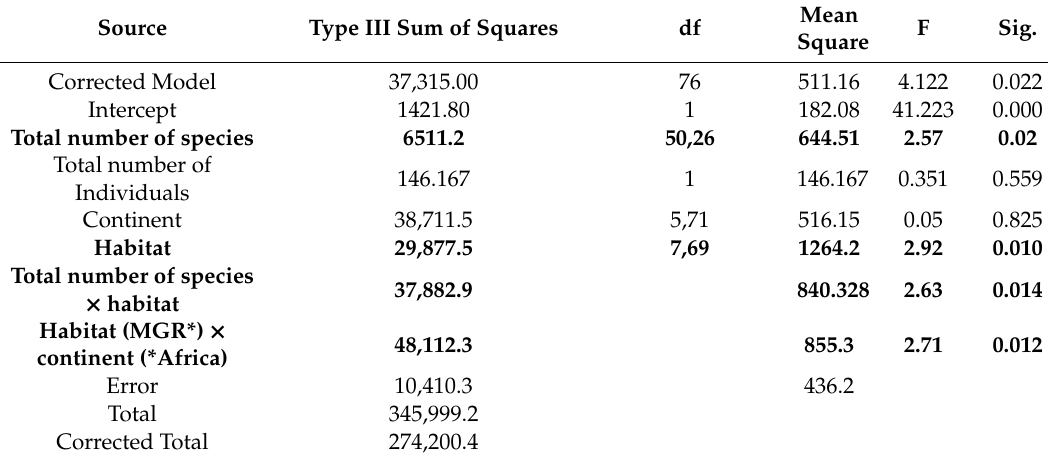
Table 8. Results of GLM regarding the probability of an increase of the frequency of venomous individuals within snake communities in relation to the various factors analyzed in the present study. Symbol: MGR = mangrove. The significant e ff ects are indicated in